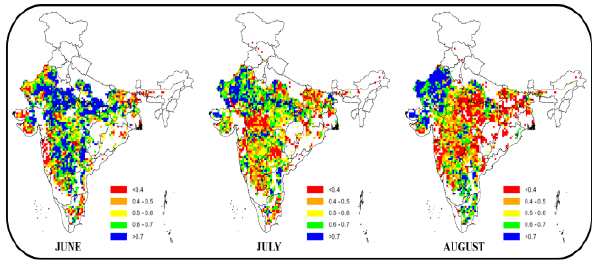
Figure 7: Correlation between soil moisture and